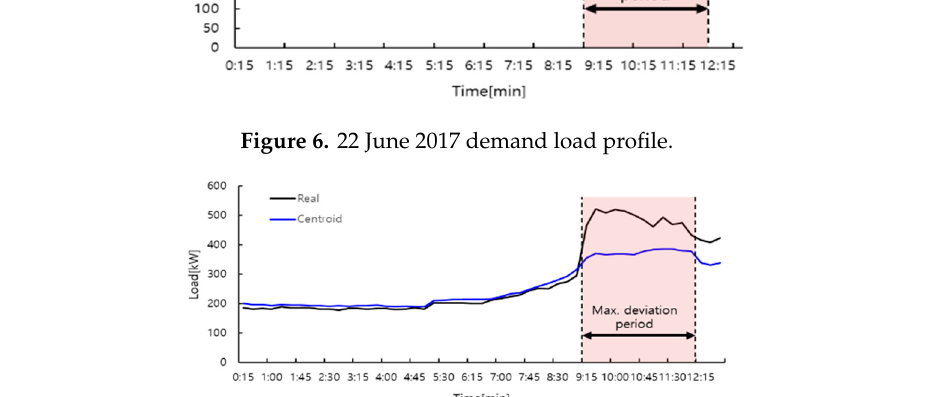
Algorithm 2: Variance Error Correction Model